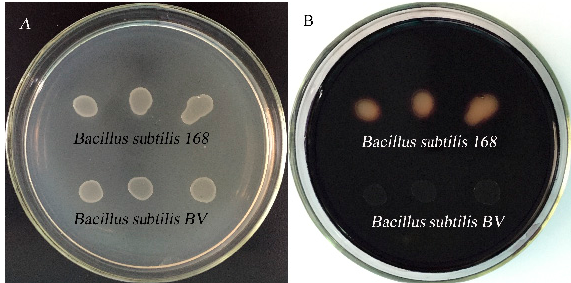
Figure 5. Starch hydrolysis test. ( A ) Bacillus subtilis 168 and recombinant B. subtilis BV cultivate on medium containing 1% starch. ( B ) The plate stained with iodine.